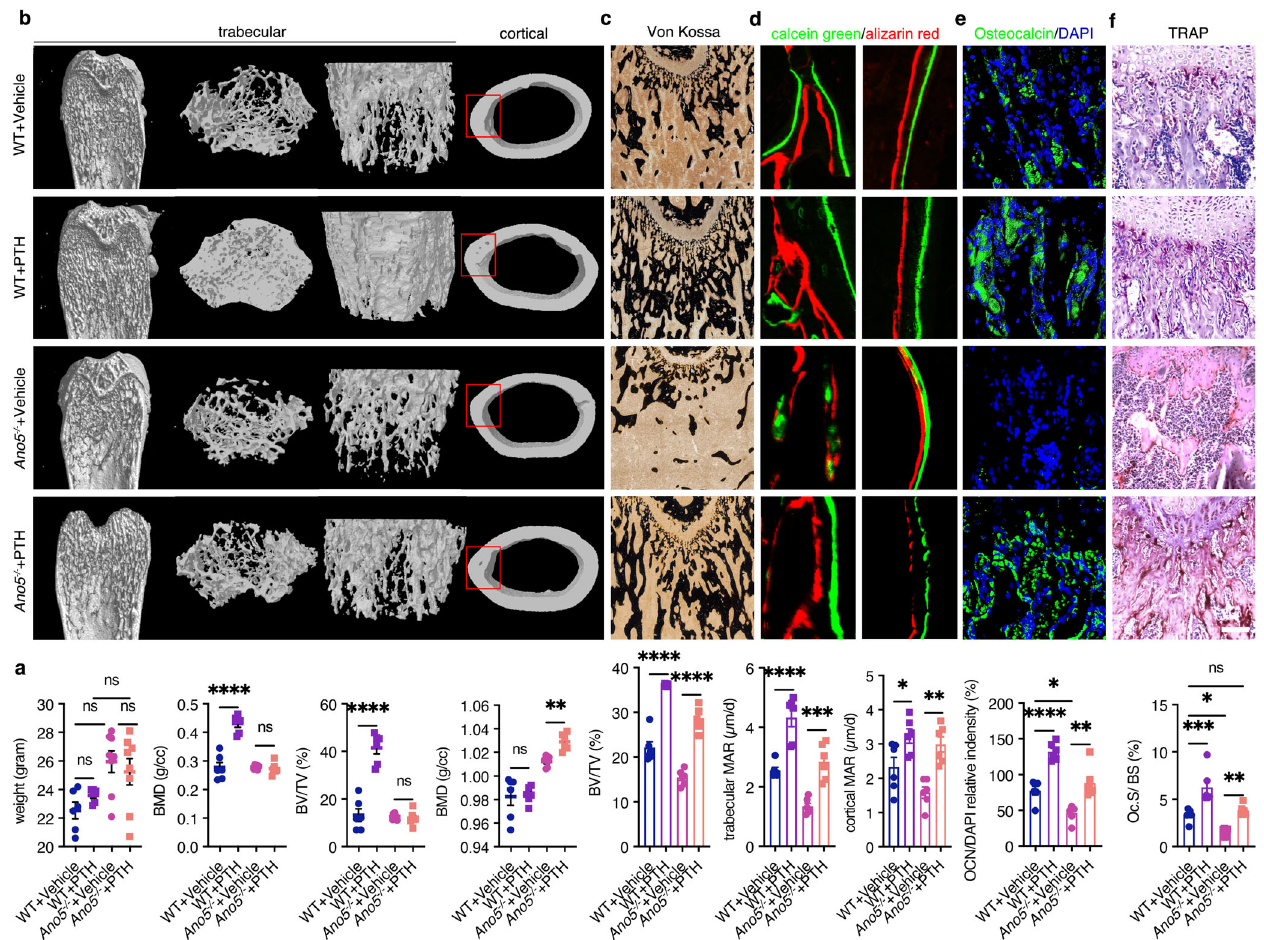
Fig. 6 PTH enhances bone strength in osteopenia. a Growth weight of 8-week-old WT and Ano5 − / − male mice after PTH treatment and vehicle treatment. b μ CT and 3D reconstruction of the trabecular and cortical femurs of 5-week-old WT and Ano5 − / − male mice after 3 weeks of PTH and vehicle treatment, and quanti fi cation of BMD and BV/TV. c Femur sections were stained with Von Kossa stain, and BV/TV was quanti fi ed. d Dynamic histomorphometry of trabecular and cortical femurs, quanti fi cation of MAR. e Femur sections were stained with OCN immunohistochemistry for quanti fi cation of relative OCN intensity. f Femur sections were stained with TRAP stain and quanti fi ed by Oc.S/BS. N = 6 for each group. Scale bar for sections, 100 µm. Data are represented as the mean ± SEM. Two-way ANOVA was followed by Tukey ’ s multiple comparisons test. * P < 0.05, ** P < 0.01, *** P < 0.001, **** P < 0.0001; ns: not signi fi cant P >